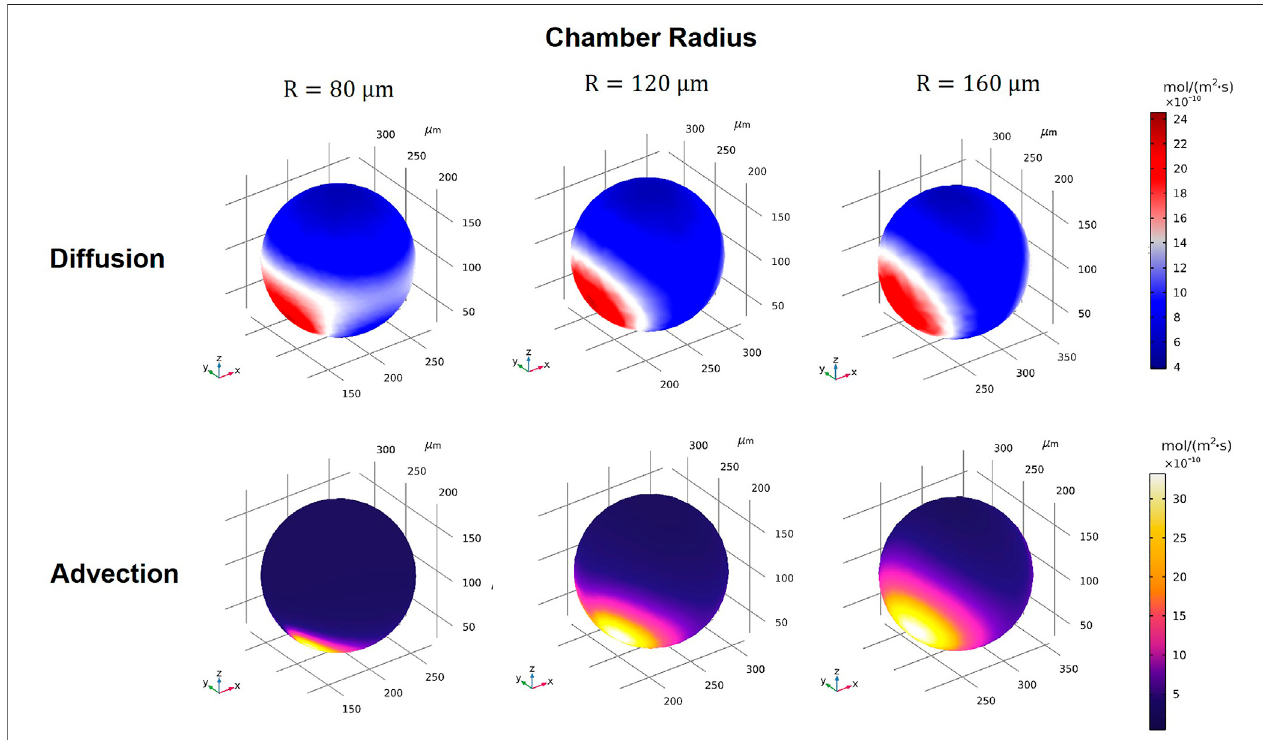
FIGURE 6 | 3D volume contours of diffusion and advection fl uxes for different microwell sizes of R (cid:2) 80, 120, and 160 μ m (W R (cid:2) H R (cid:2) W L (cid:2) H L (cid:2) 25 µm).